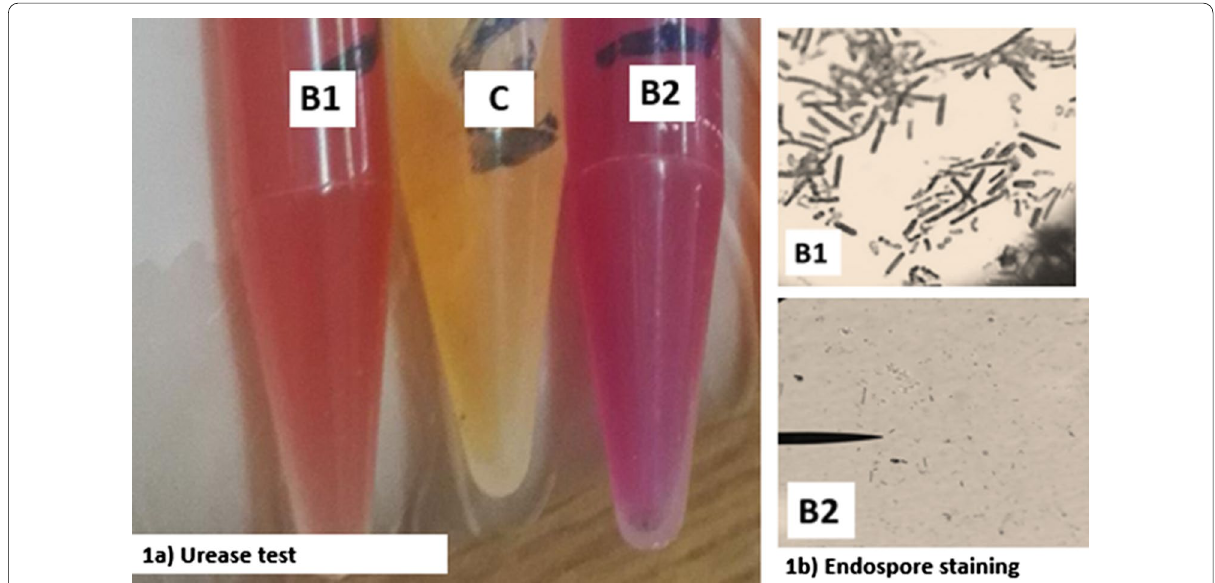
Fig. 1 a C is the control without bacterial inoculum. B1 and B2 are the bacterial isolates that gave dark pink color after 24 h. Indicating positive urease results using Phenol red as indicator. b Shows that B1 and B2 bacterial isolates are bacilli cells and their endospores appeared as dark black colored spherical dots